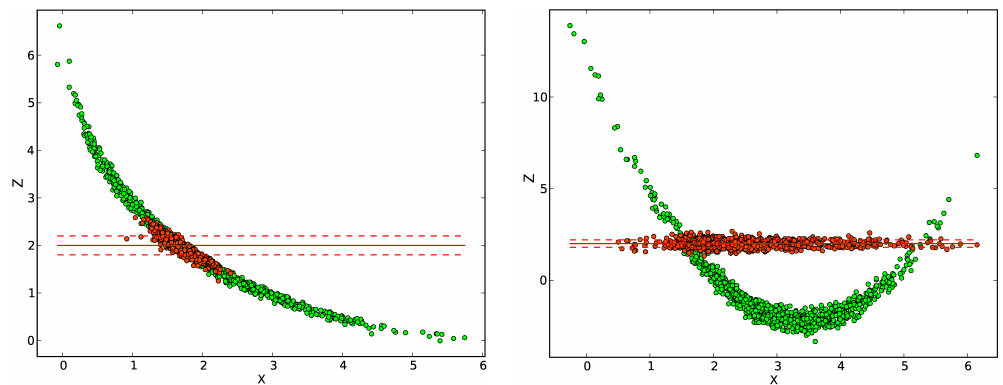
Figure 2. Same as Fig. 1 but for the EnKF with Gaussian anamorphosis and for joint weakly non-Gaussian (left panel) and strongly non-Gaussian (right panel) prior distributions. The weakly non-Gaussian prior is the same as in Fig. 1 (right panel).